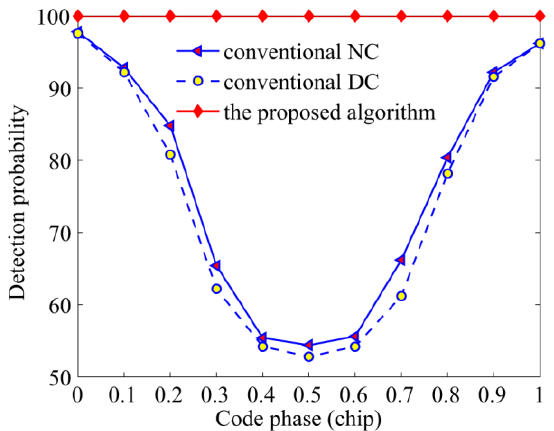
Figure 10. Detection probabilities of the NC, DC, and the proposed algorithms against the code phase.